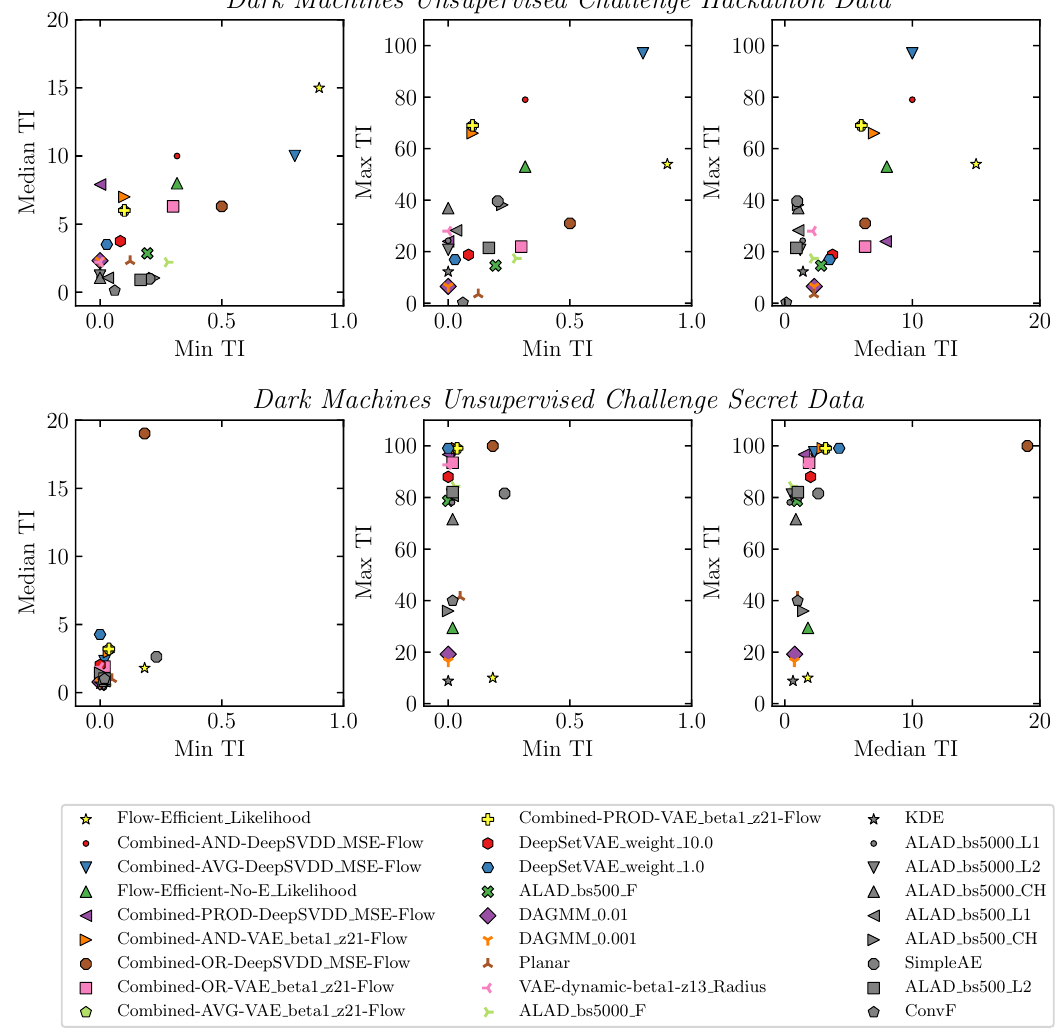
Figure 23: The minimum, median, and maximum best total improvements for each technique applied on each of the signals in the Hackathon (top) and Secret (middle)